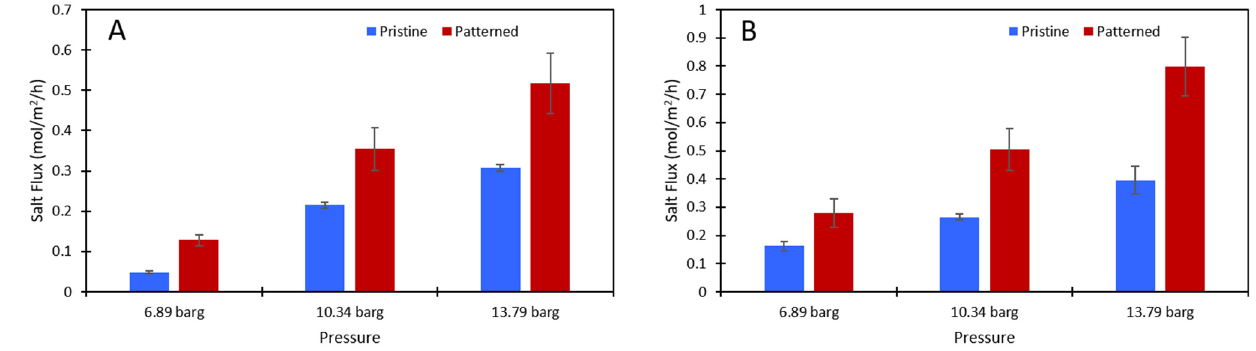
Figure 6. The salt flux (mol/m 2 /h) data for ( A ) the 2000 ppm Na 2 SO 4 feed solution and ( B ) the 10,000 ppm Na 2 SO 4 feed solution. Blue is the pristine membrane, and red is the patterned membrane. The error bars represent one standard deviation among at least three samples.